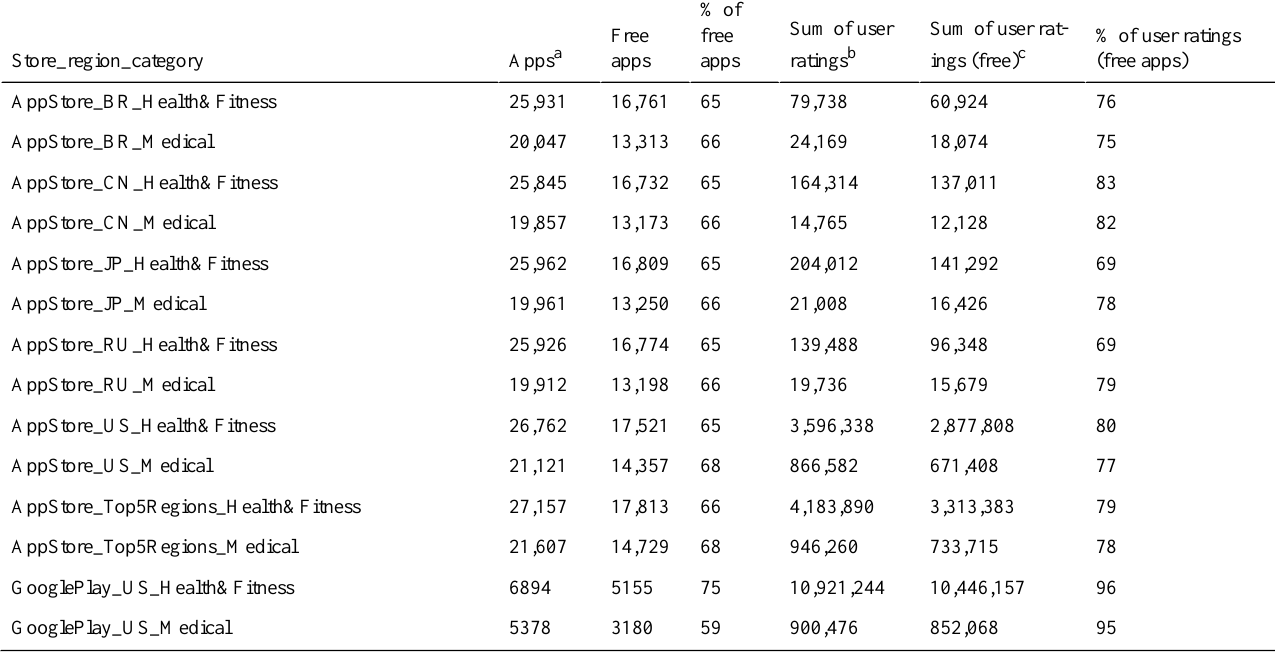
% of apps)Sum of user rat- Sum of user % of user ratings free appsFree (free ings (free) c ratings b